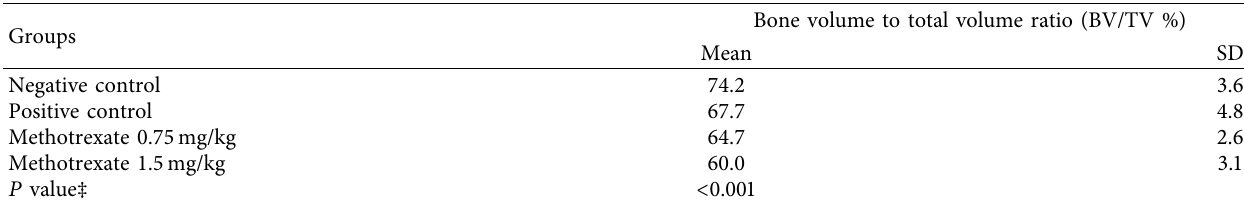
Table 3: Mean BV/TV in the experimental and control